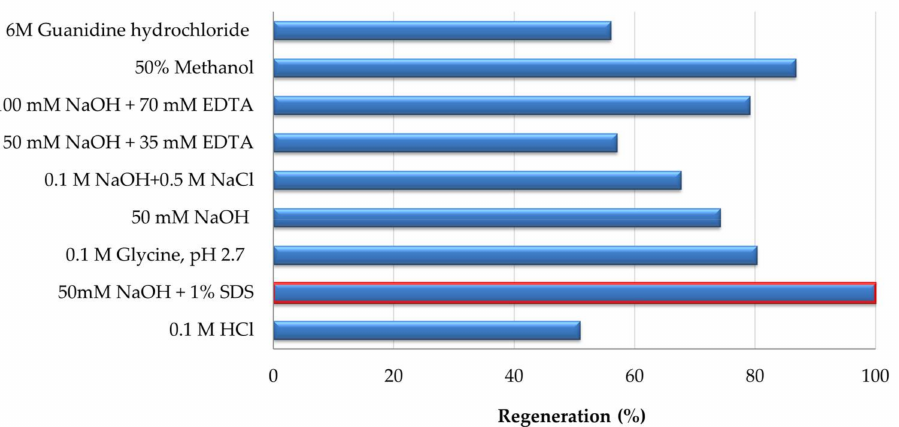
Figure 3. Regeneration of OTA immobilized sensor surface by using different regeneration solutions. The regeneration solution which provided 100% regeneration efficiency (50 mM NaOH and 1% SDS) was highlighted with the red